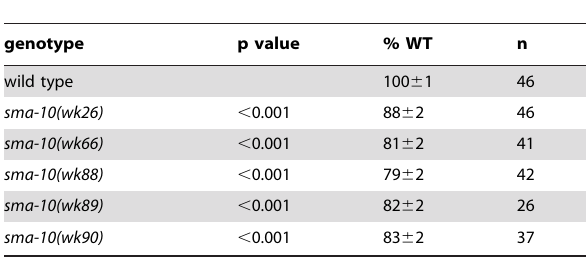
Table 1. Quantitation of sma-10 mutant body size.